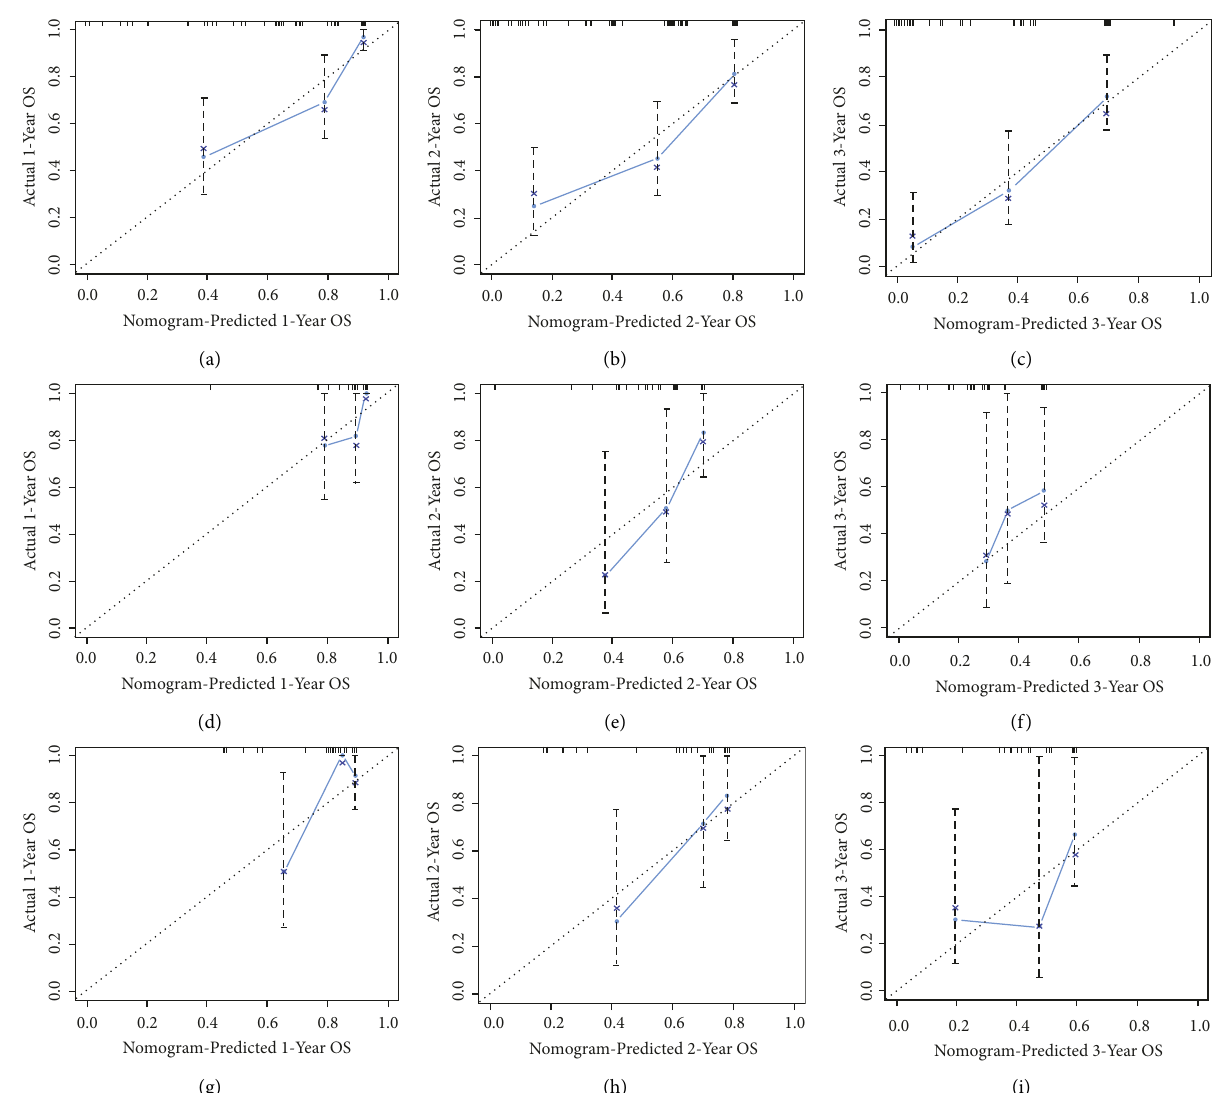
Figure 6: Calibration curves of 12-month, 24-month, and 36-month survival rates in the training set (a-c), internal validation set (d-f), and external validation set